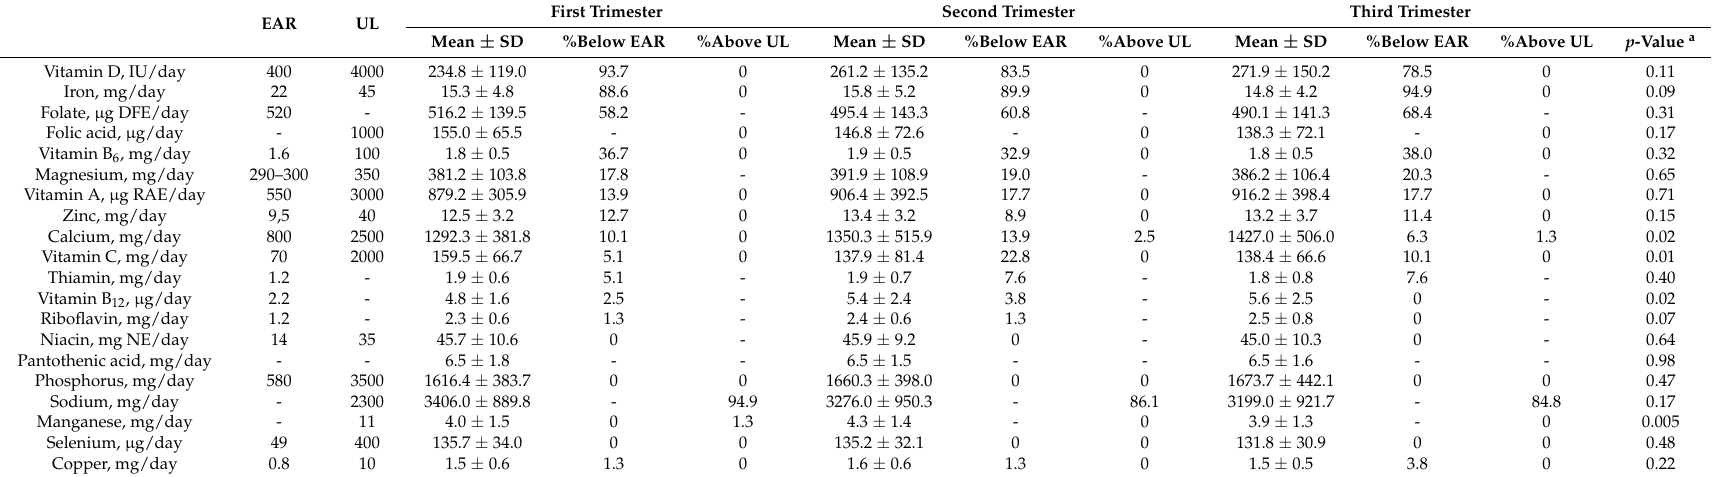
Table 4. Trimester-specific micronutrient intakes from food alone in comparison with dietary reference